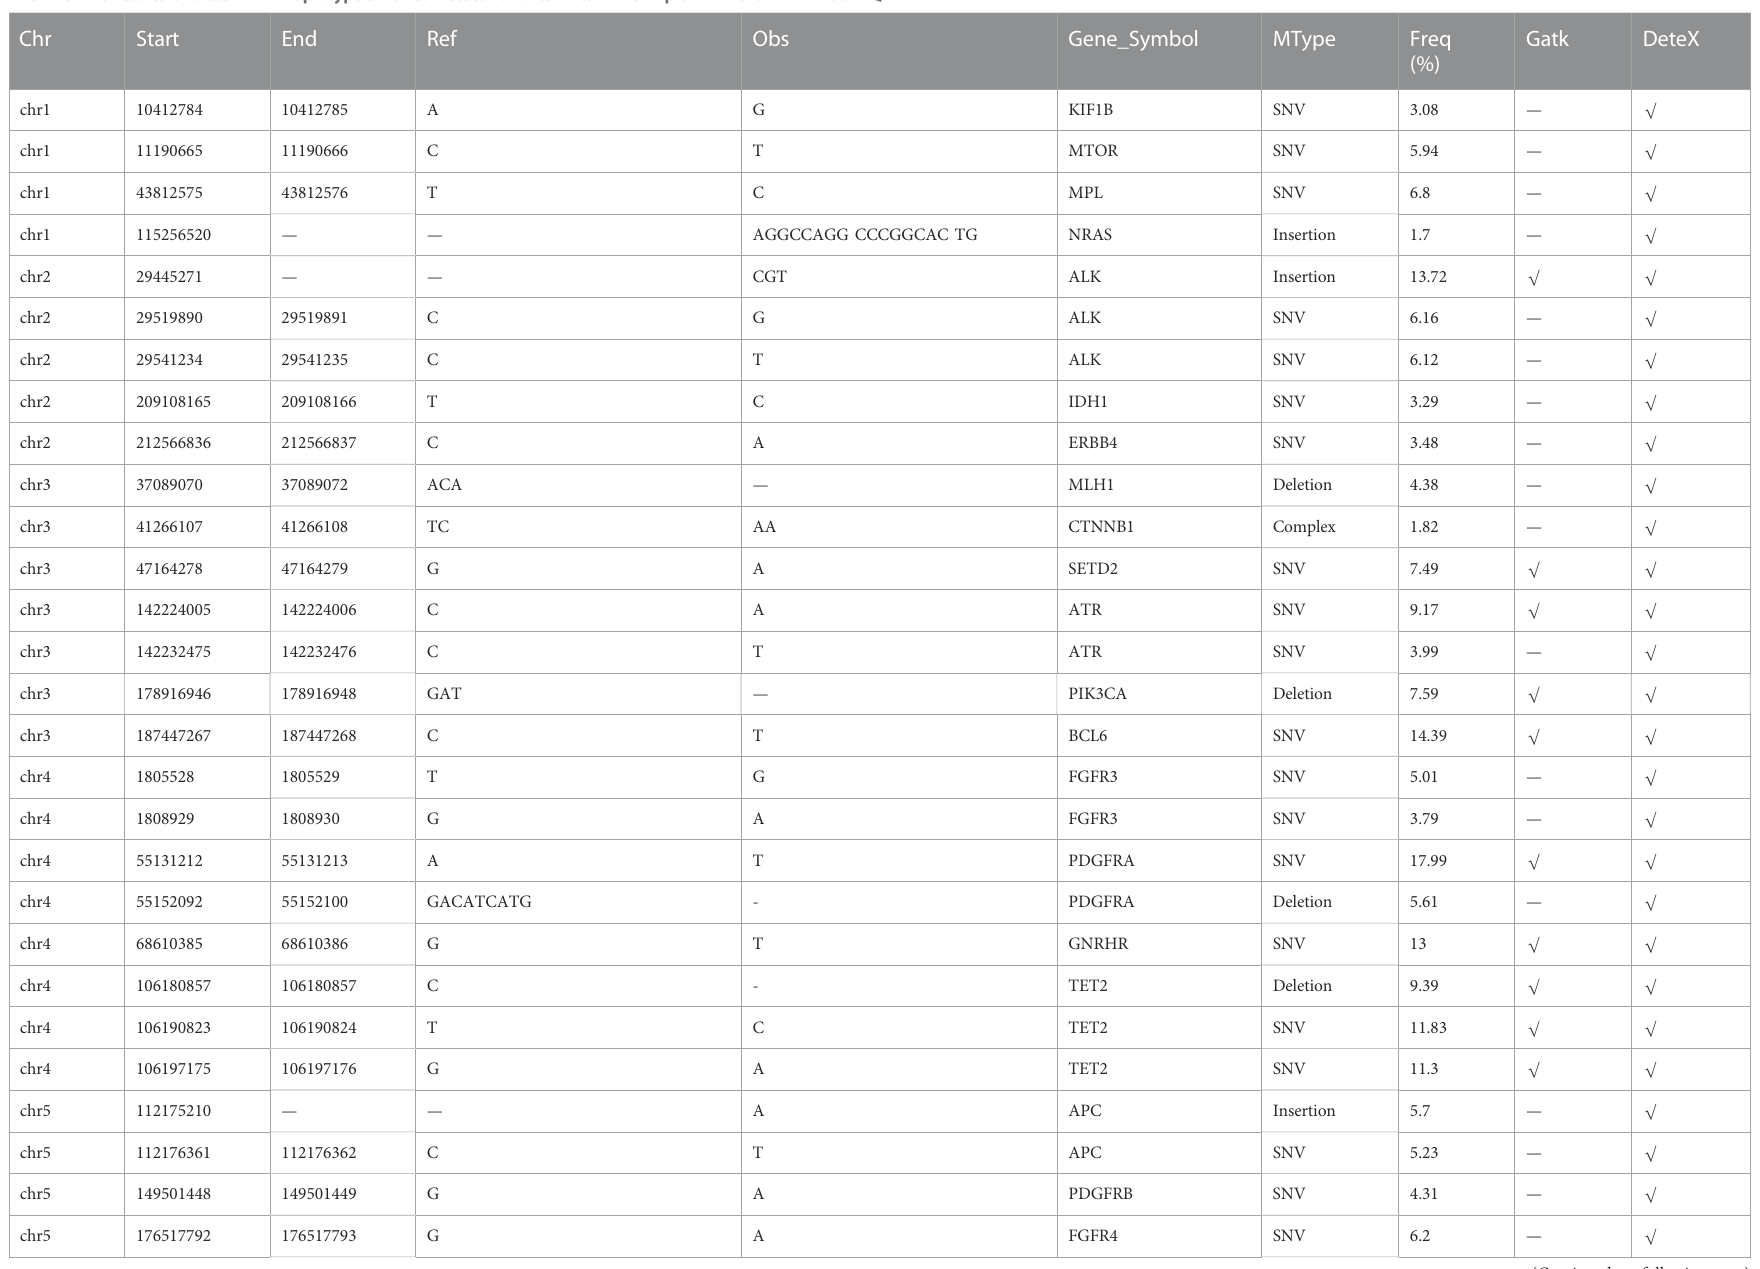
TABLE 5 The results of DeteX and HaplotypeCaller to detect variants in tumor sample from the 2017